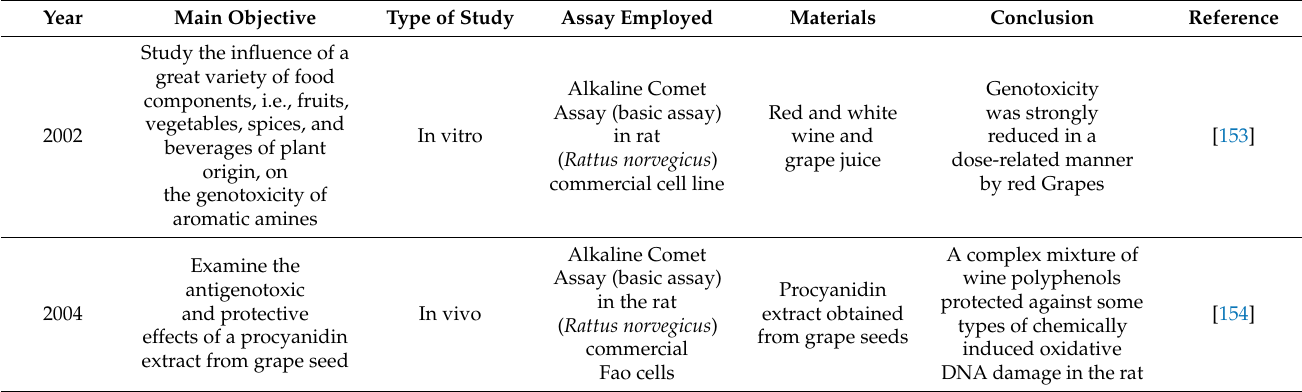
Table 5. Relevant studies of